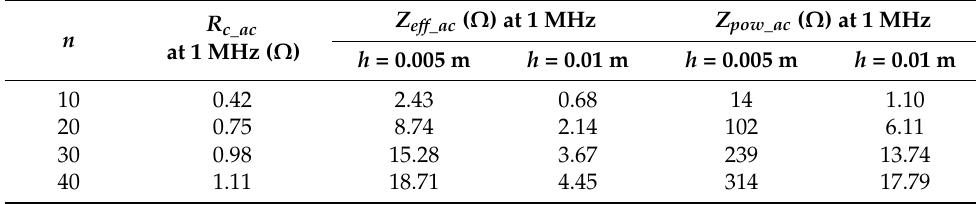
Table 4. Calculated circuit parameters for r = 0.01 m (with skin effect).